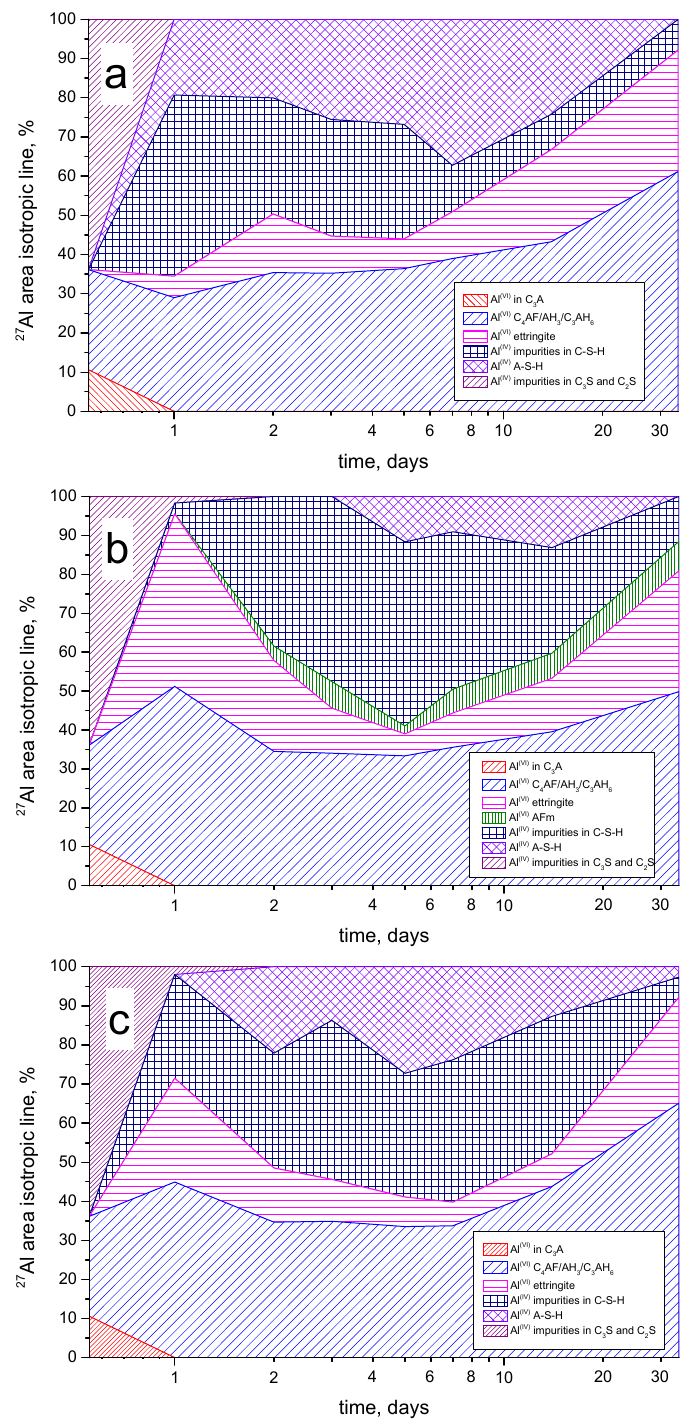
Figure 5. Time-evolution (in logarithmic scale) of the relative integrated areas of the isotropic components recognized in the 27 Al NMR spectra of the samples: C ( a ), CAA ( b ) and CSA ( c ).